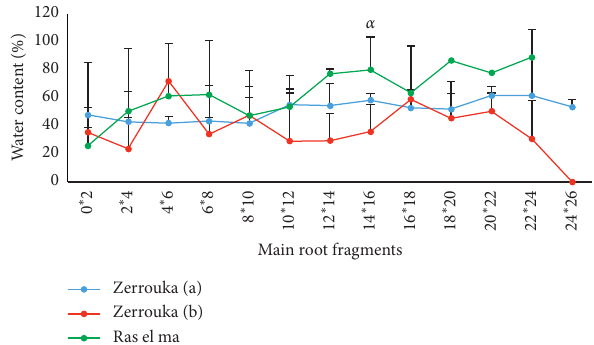
Figure 2: Distribution of water in the secondary roots attached to the fragment of the main root. 0 ∗ 2 means fragment 0 to 2cm. The values marked with α indicate at least one significant difference at the fragment level ( P < 0 . 05, n � 3).